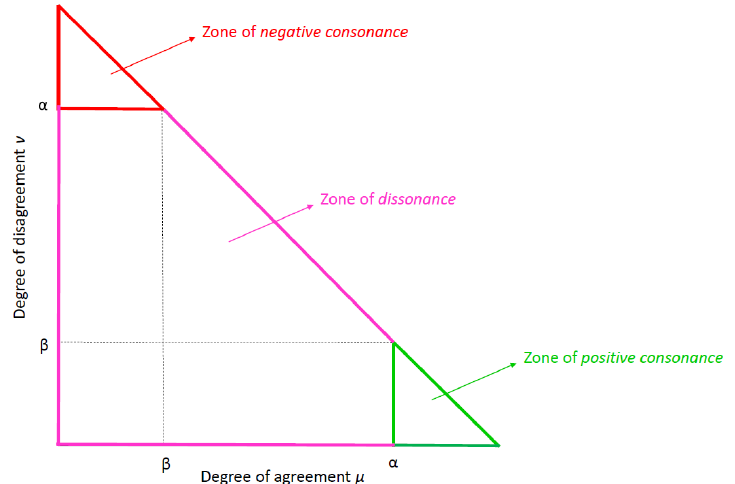
Figure 4. Intuitionistic fuzzy triangle with zones of positive consonance , negative consonance and dissonance.